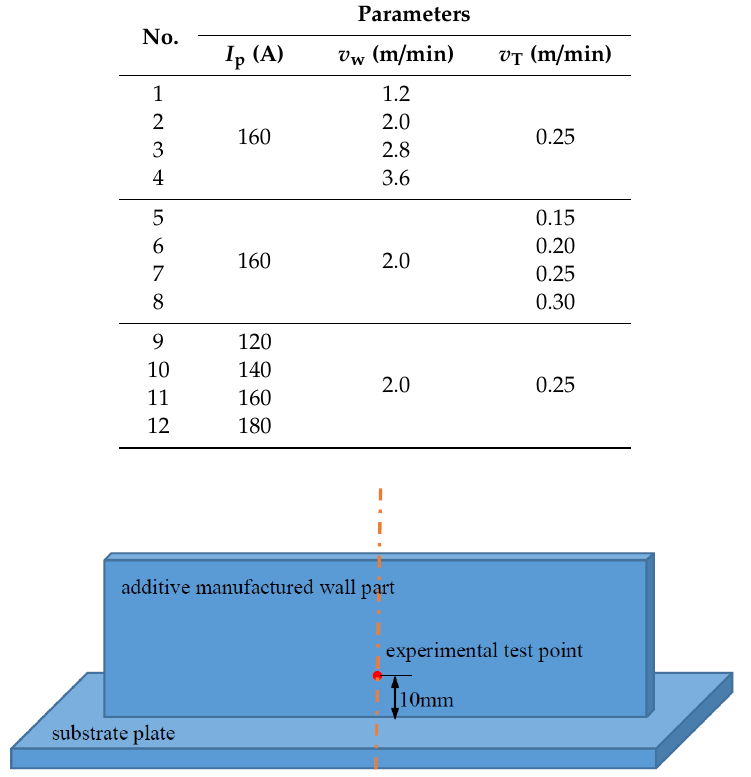
Table 2. Variable design for thermal boundary investigation.